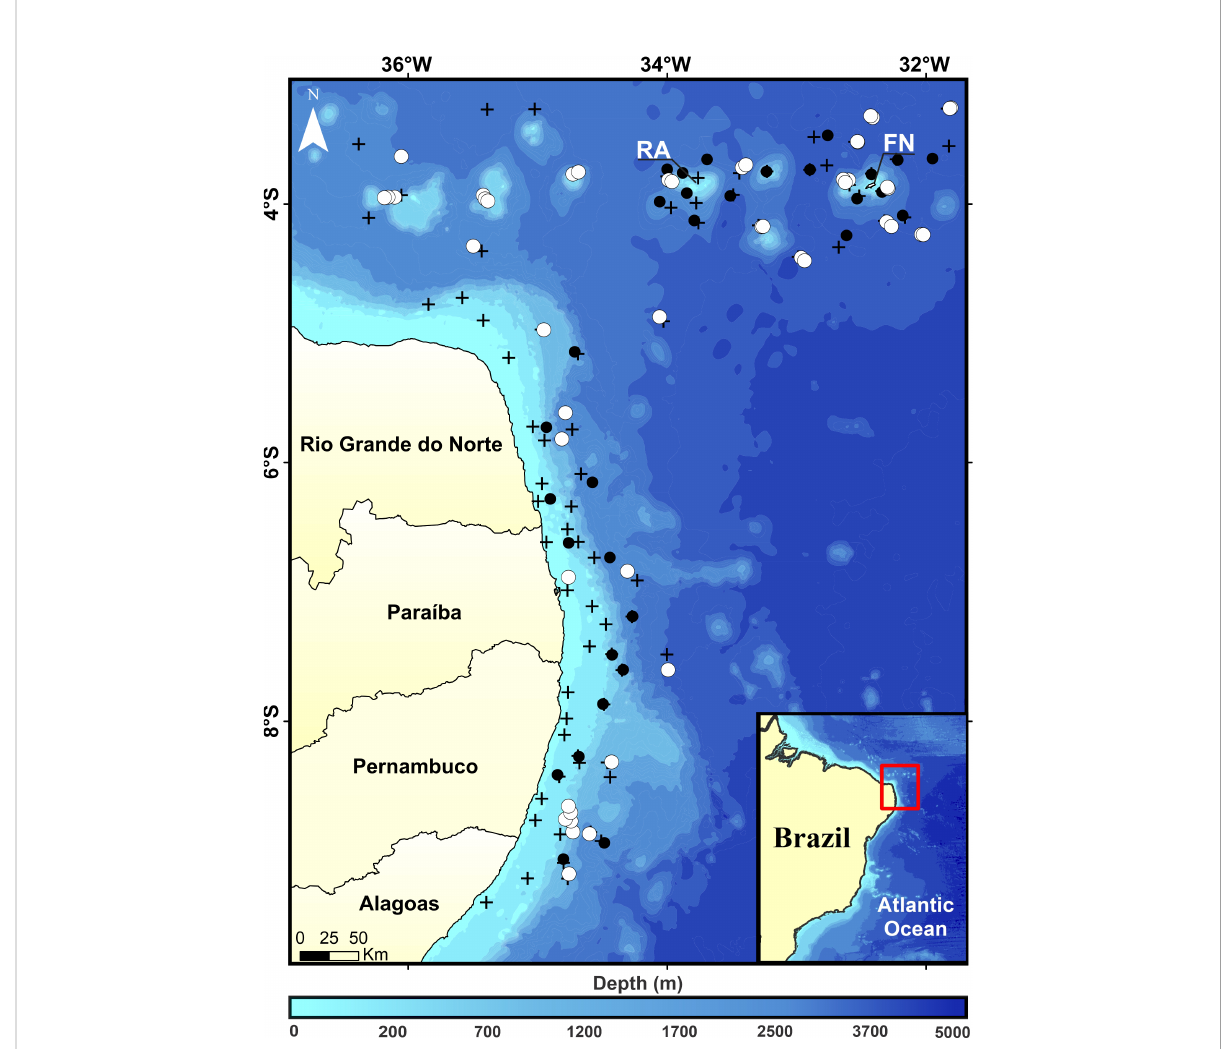
FIGURE 1 Study area with CTDO pro fi le (cross) and trawl samples (dots). Black and white symbols for ABRACOS 1 and ABRACOS 2,